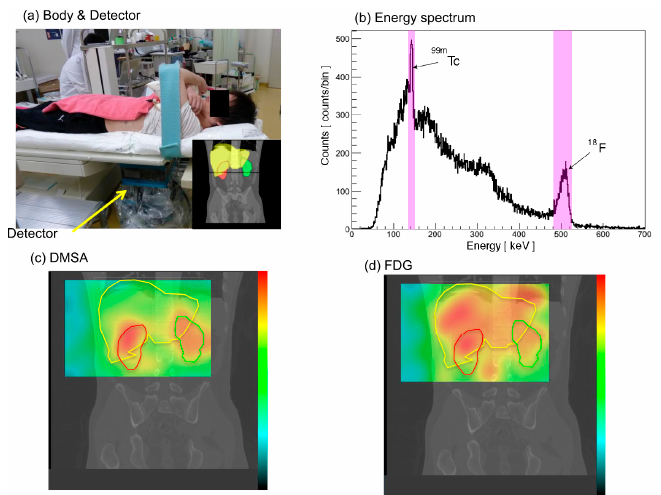
Figure 8. ( a ) Human experiment setup using Compton camera. ( b ) Energy spectrum obtained in the study. ( c ) Compton image overlaid with CT image for 99m Tc DMSA radiopharmaceuticals. ( d ) Compton image overlaid with CT image for 18 F FDG radiopharmaceuticals. All the images are reprinted from Nakano et al. [84]. Reprinted with permissions from Nakano et al. [84].